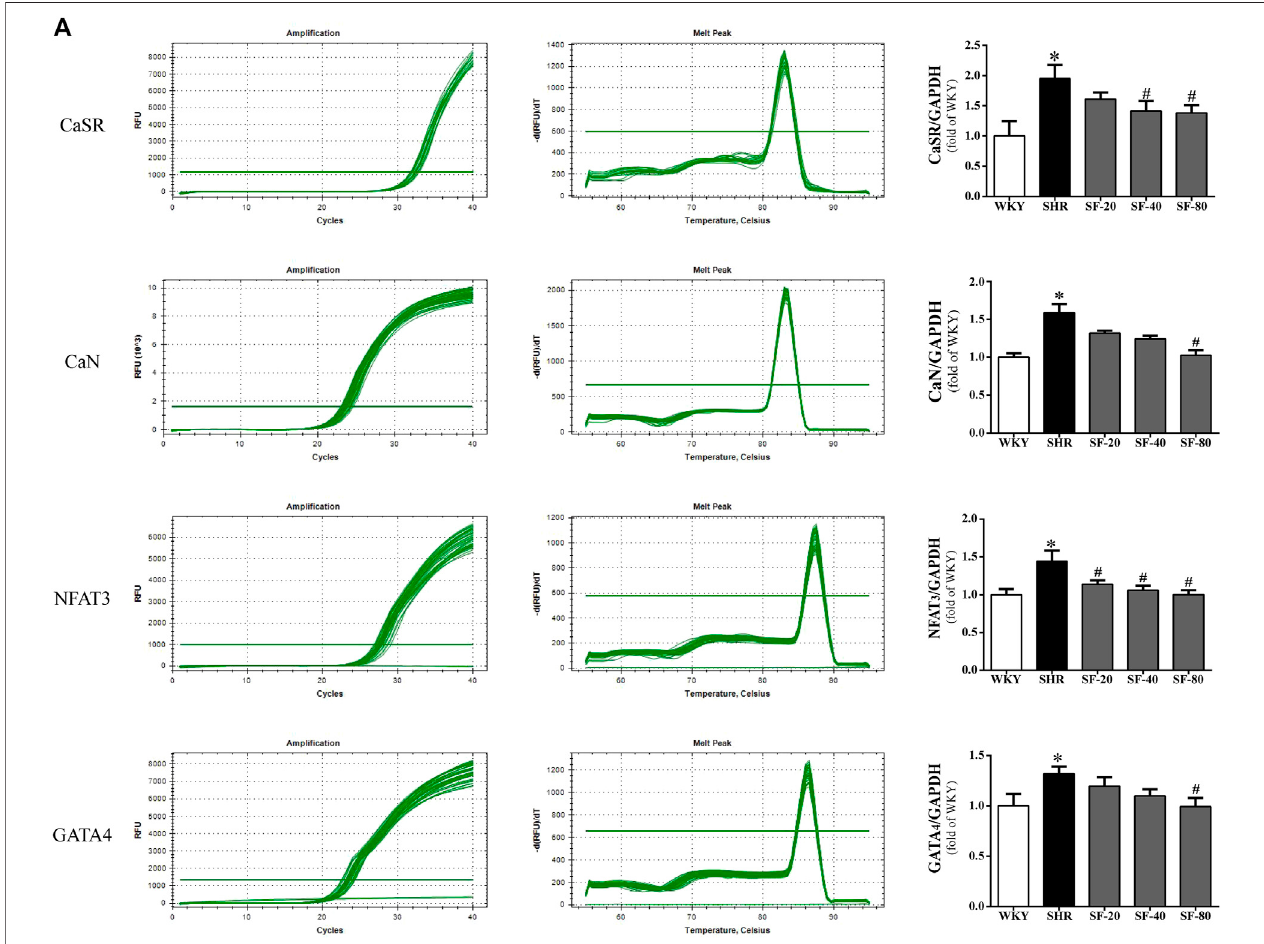
FIGURE 6 | SF improves cardiac hypertrophy by regulating CaSR, CaN, NFAT3, and GATA4 levels. (A) Quantitative analysis of CaSR, CaN, NFAT3, and GATA4 mRNA levels. ( n (cid:1) 5). (B) quantitative analysis of CaSR, CaN, p-NFAT3, NFAT3, and GATA4 protein level. ( n (cid:1) 3). The levels of CaSR, CaN, NFAT3, and GATA4 were signi fi cantly upregulated in the myocardium of SHRs at the transcriptional and translational levels, and the level of p-NFAT3 protein in the cytoplasm was signi fi cantly downregulated. SF downregulated the levels of CaSR, CaN, NFAT3, and GATA4 and upregulated the level of p-NFAT3 protein in the cytoplasm in the left ventricular myocardial tissue of SHRs. Data are presented as mean ± SEM. *signi fi cantly different from WKY at p < 0.05; # signi fi cantly different from SHRs at p < 0.05.